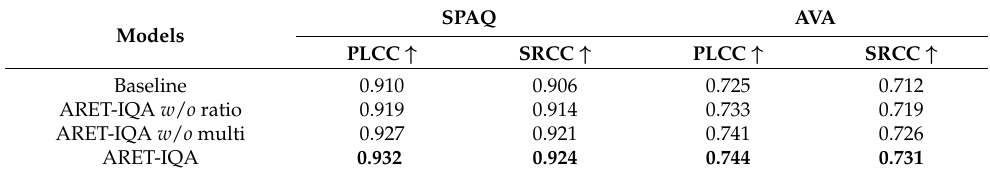
Table 4. Ablation study results (SRCC and PLCC) of the proposed ARET-IQA (384) on the SPAQ [27] and AVA [11] databases, where the best results on each database are highlighted in bold